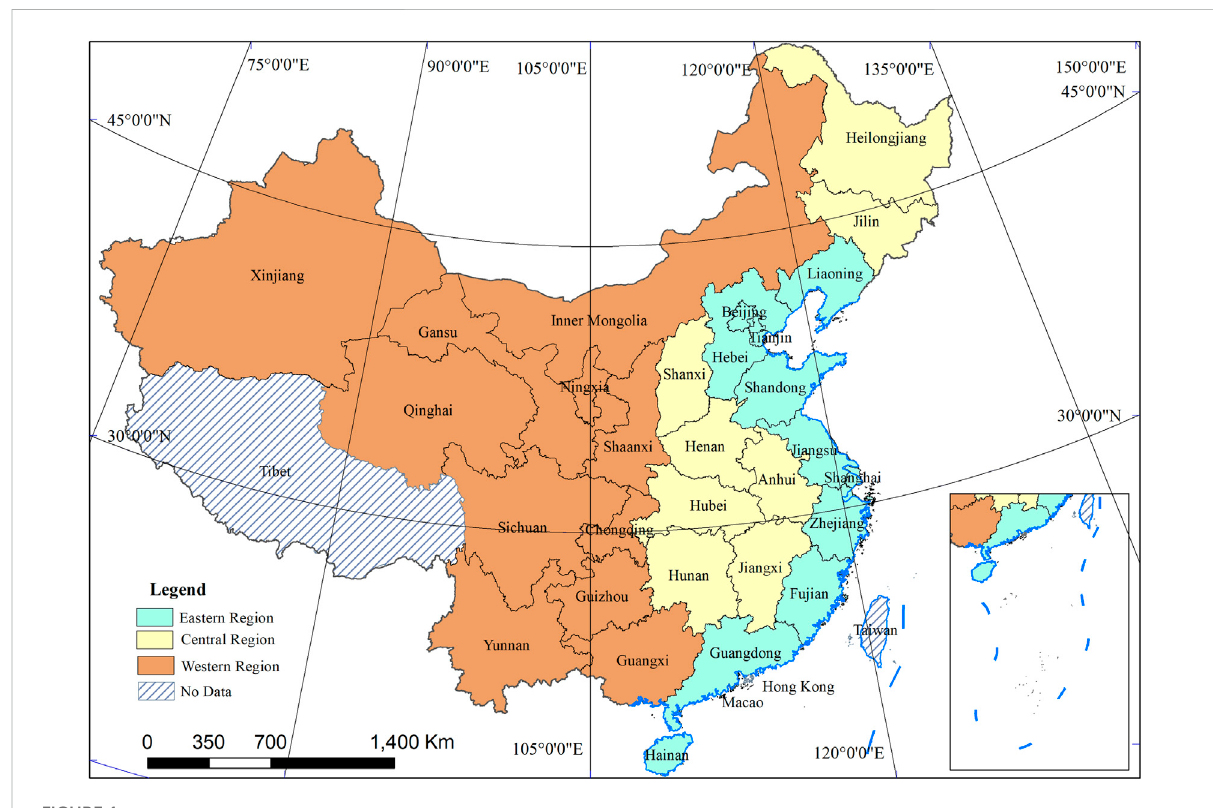
FIGURE 1 Location of the study area and regional classi fi